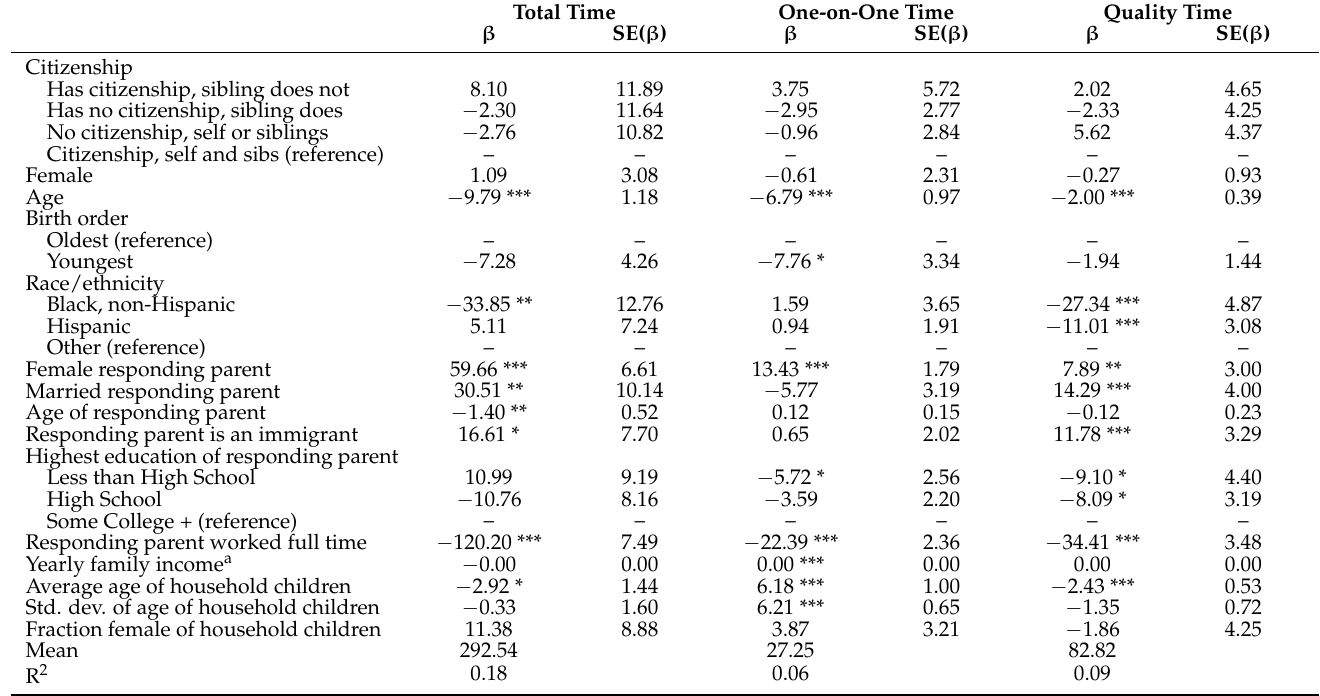
Table 3. Associations between Childhood Citizenship Status and Parental Time Investments (N = 13,012). Total